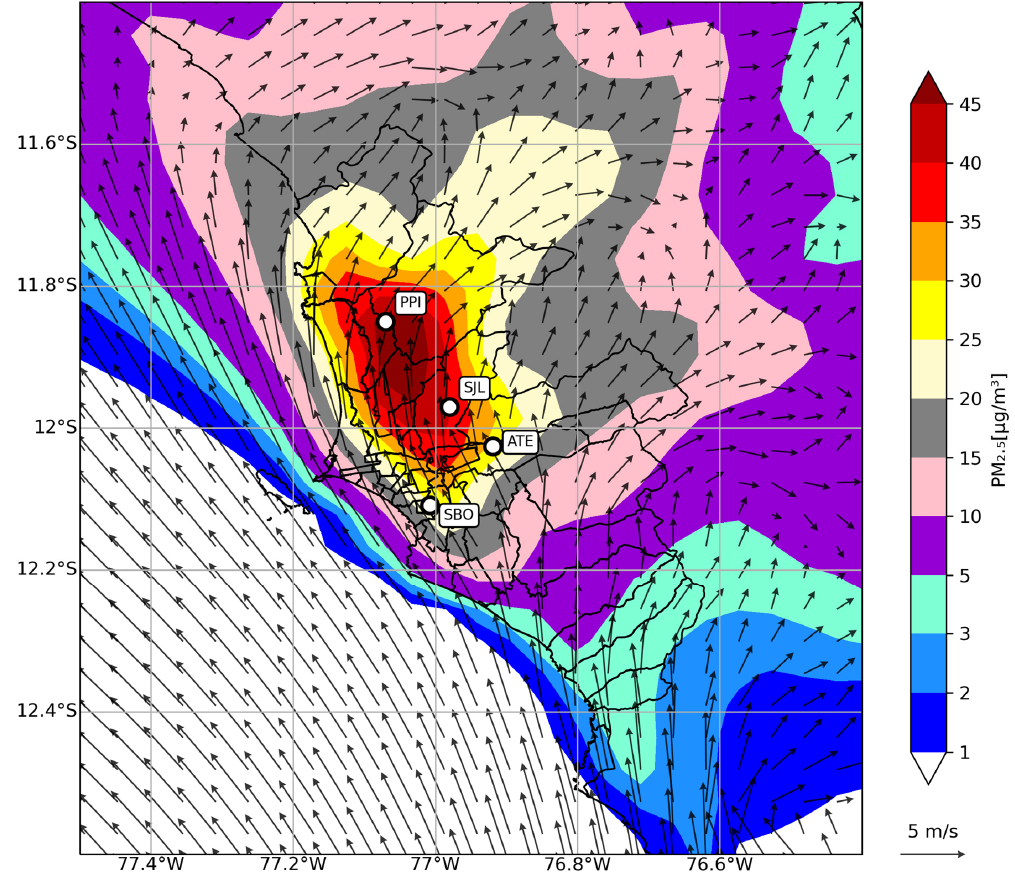
in addition, for PPI AAQMS, the simulated PM 2.5 concentration was 45 µ g/m 3 . The mean simulated values for PM 2.5 concentration for the control in all study areas of the MALC were 15–45 µ g/m 3 . Moreover, the prevailing wind direction during our study period was from the south of the MALC; therefore, low concentrations of PM 2.5 remain in the southern regions of Lima and high values were simulated for the northern regions of Lima, such as PPI (Figure 8).